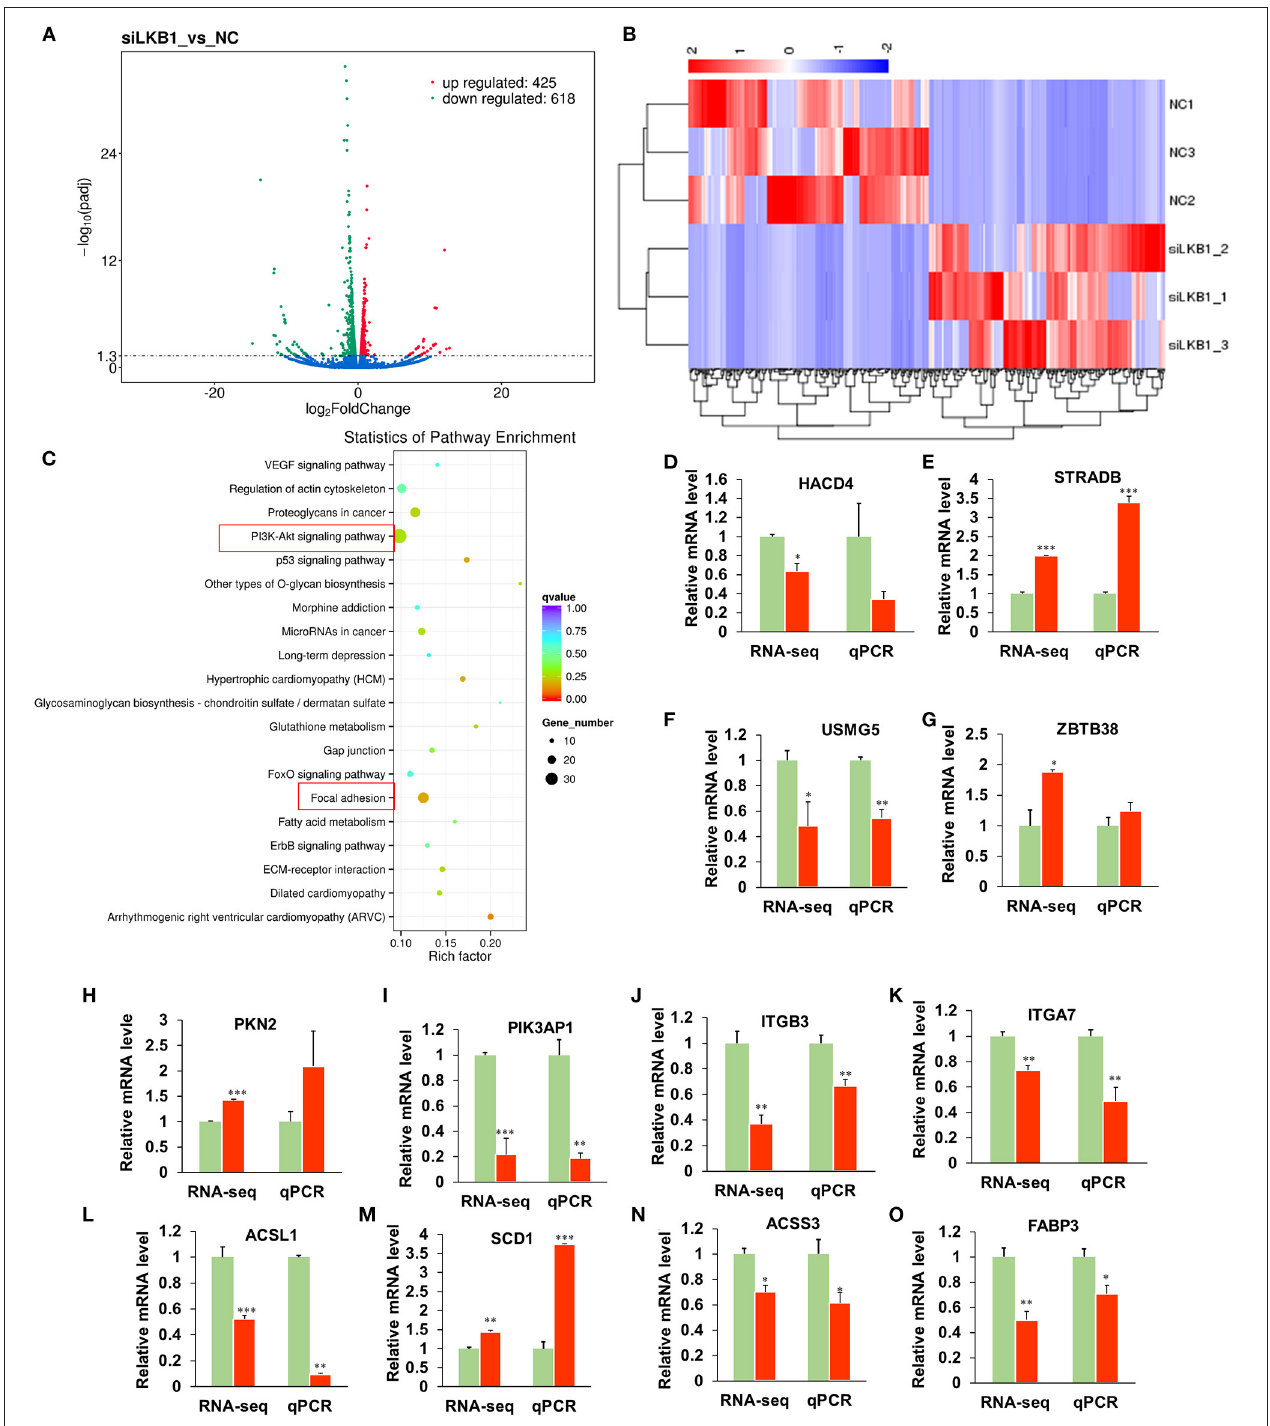
FIGURE 6 | Knockdown of LKB1 affects the mRNA transcript profiles. (A) RNA-seq volcano plot of significantly differential expression genes (DEGs) in siLKB1 ( n = 3) vs. NC ( n = 3) goat intramuscular adipocytes. Red and blue dots denote upregulated and downregulated genes, respectively. P < 0.05 is indicated by the gray dashed horizontal lines. (B) The heat map showing the relative levels (fold changes = siLKB1 signal/NC signal) of DEGs. (C) The KEGG pathway analysis of related DEGs. (D–O) Verification of representative DEGs by qPCR ( n = 3), including 3-hydroxyacyl-CoA dehydratase 4 (HACD4), STE20-related adaptor beta (STRAD), upregulated during skeletal muscle growth protein 5 (USMG5), Zinc finger and BTB domain containing 38 (ZBTB38), protein kinase N2 (PKN2), phosphoinositide-3-kinase adaptor protein 1 (PIK3AP1), integrin subunit beta 3 (ITGB3), integrin subunit alpha 7 (ITGA7), acyl-CoA synthetase long-chain family member 1 (ACSL1), stearoyl-CoA Desaturase 1 (SCD1), acyl-CoA synthetase short-chain family member 3 (ACSS3), fatty acid-binding protein 3 (FABP3). * P < 0.05, ** P < 0.01, *** P < 0.001. LKB1, liver kinase B1; NC, negative control.